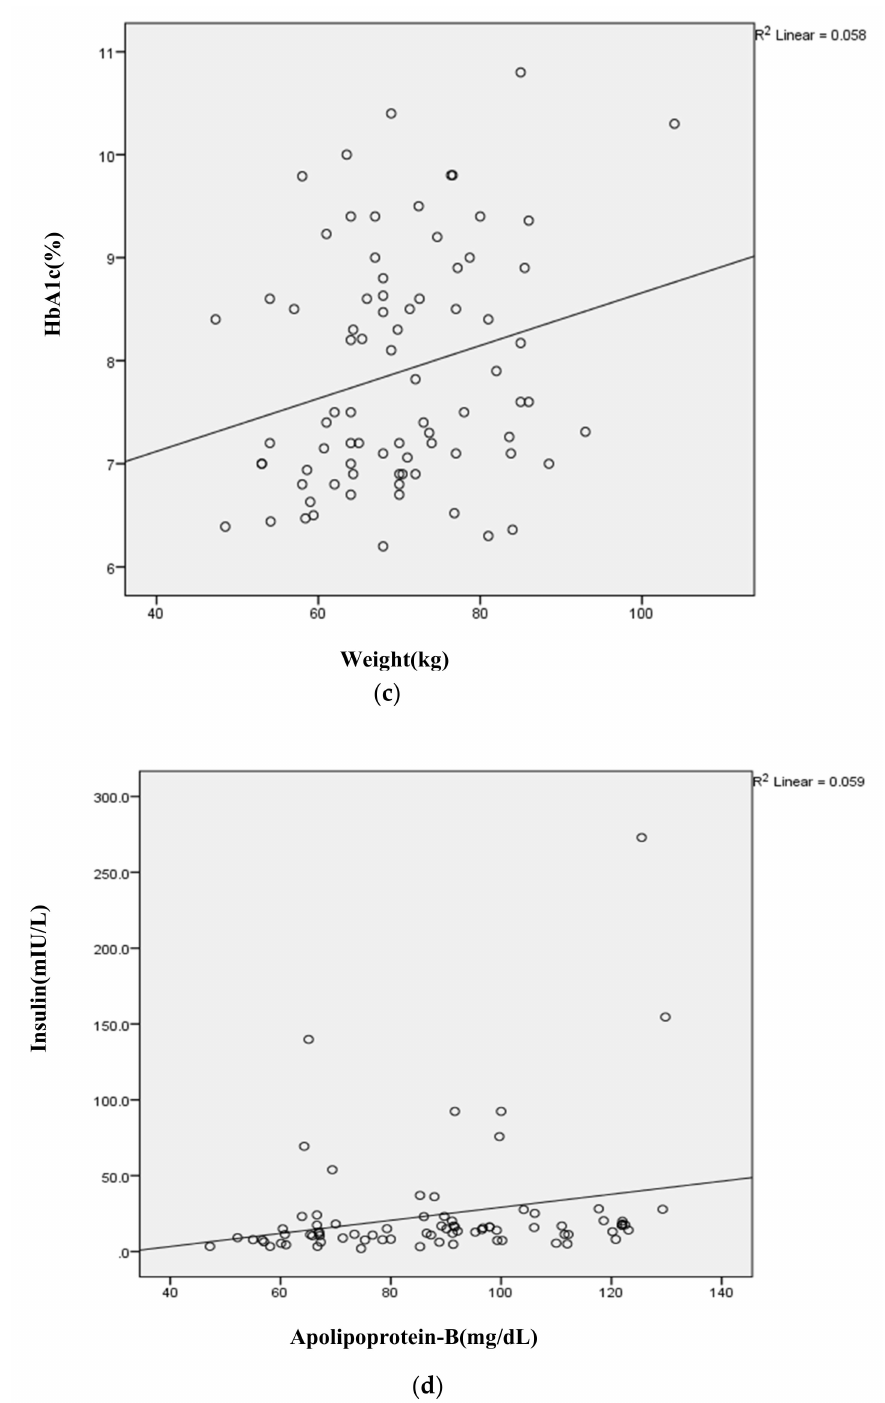
Figure 2. Correlation of weight with anthropometric and biochemical parameters: ( a ) The correlation of weight with WC (waist circumference); ( b ) PPBS (postprandial blood sugar); ( c ) HbA1c after 24 weeks of dietary intervention. ( d ) Correlation of apolipoprotein B with fasting insulin after 24 weeks of dietary